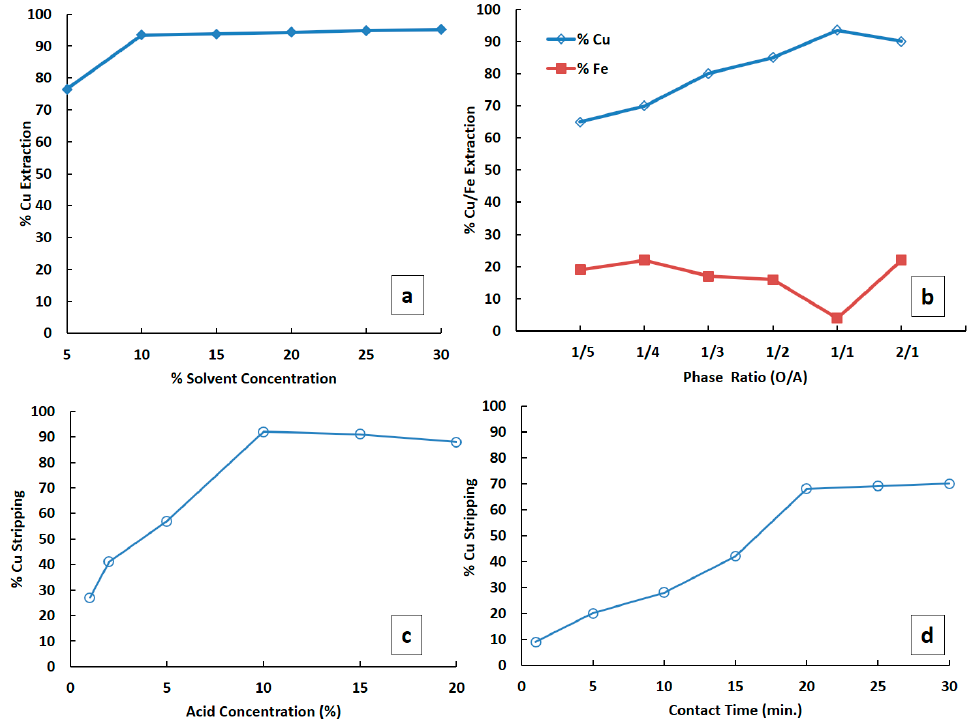
Figure 13. Variation of solvent extraction parameters for separation and stripping of copper from the bacterial PLS using Acorga M5640 at 30 °C [( a ) variation of solvent concentration (O/A:1); ( b ) variation in phase ratio (10% Acorga); ( c ) concentration of stripping reagent; ( d ) contact time of stripping].